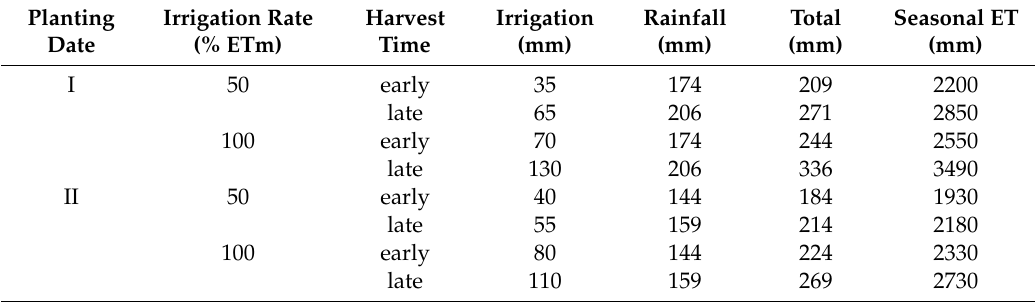
Table 1. Total water intercepted by the crop (water supplied by irrigation and rainfall) and